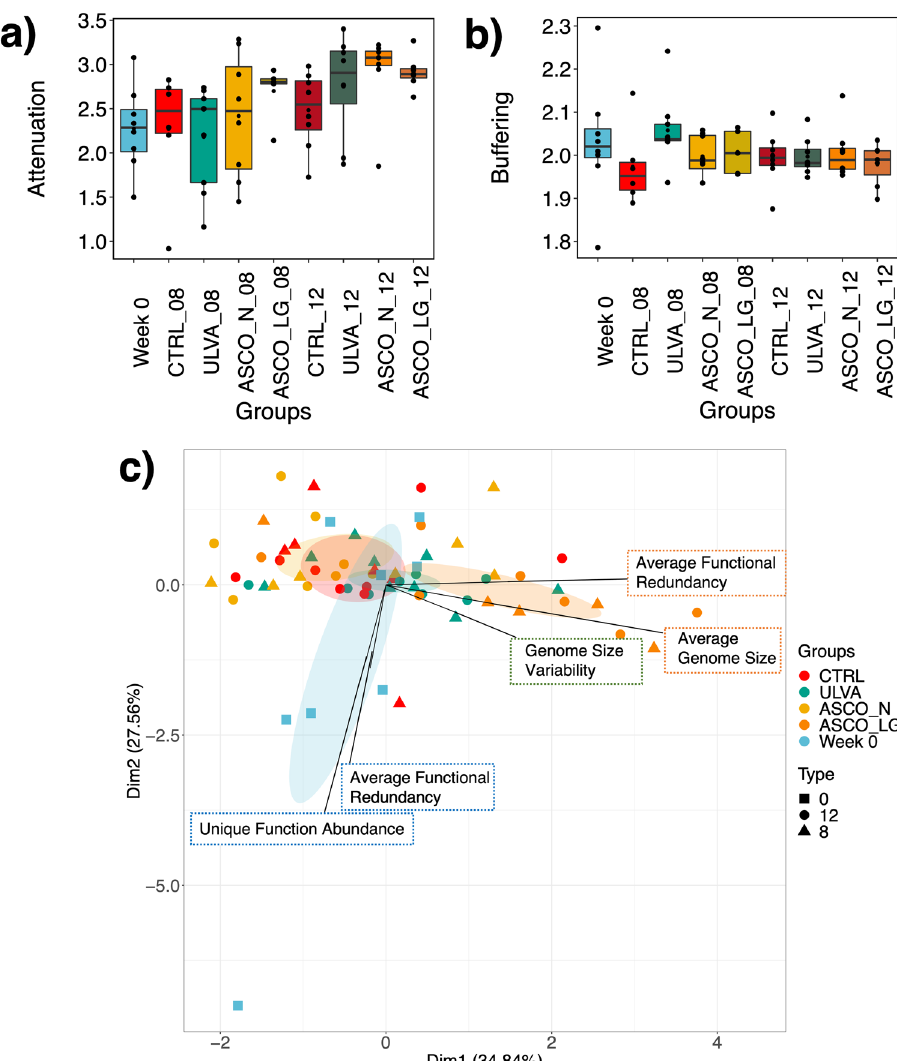
Fig. 5 How robust is the gut microbiota of Atlantic cod to taxonomic perturbation? a Potential robustness to perturbation magnitude (attenuation) increased over time in the hindgut of juvenile Atlantic cod, with highest values in the ASCO_LG dietary treatment. In the boxplots, center value lines indicate the median, boxes indicate the lower/upper quartiles (25%/75%) and lines extending parallel from the boxes (whiskers) show the variability outside the upper and lower quartiles. Lines connecting categories shows signi fi cant relationships (pairwise t-test) with *( p < 0.05), **( p < 0.01), or ***( p < 0.001). b Potential buffering capacity towards functional perturbation was relatively stable over time and across treatment groups. In the boxplots, center value lines indicate the median, boxes indicate the lower/upper quartiles (25%/75%) and lines extending parallel from the boxes (whiskers) show the variability outside the upper and lower quartiles. Lines connecting categories shows signi fi cant relationships (pairwise t-test) with *( p < 0.05), **( p < 0.01), or ***( p < 0.001). c The microbial communities in the hindgut of juvenile Atlantic cod were separated according to variation in gene distribution features (GDF) between Week 0 and Week 8/12 macroalgal dietary treatments. The points represent grouped samples with ‘ Time ’ denoted by symbols and dietary treatments denoted by colours; Week 0 (blue), CTRL (red), ULVA (green), ASCO_N (light orange), ASCO_LG (dark orange). The percent variance explained by each principal component is indicated on the axis labels. The line and box with the GDF name show the direction of the GDF